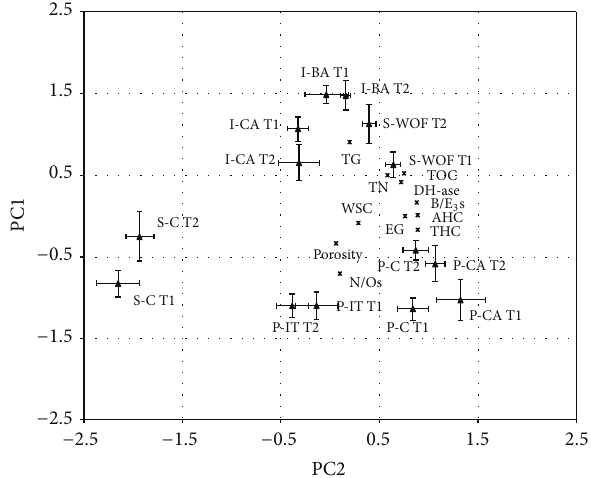
Figure 1: Biplot of factor scores and loadings at each sampling time (T1 and T2), in each treatment. TOC: total organic carbon; THC: total extractable carbon; AHC: extractable carbon fraction > 10.000 Da; TN: total nitrogen; EG: extracellular 𝛽 -glucosidase activity; TG: 𝛽 -glucosidase activity; WSC: water soluble carbon; DH-ase: dehydrogenase activity; B/E 3 s: benzene/toluene whole soil; and N/Os: furfural/pyrrole whole